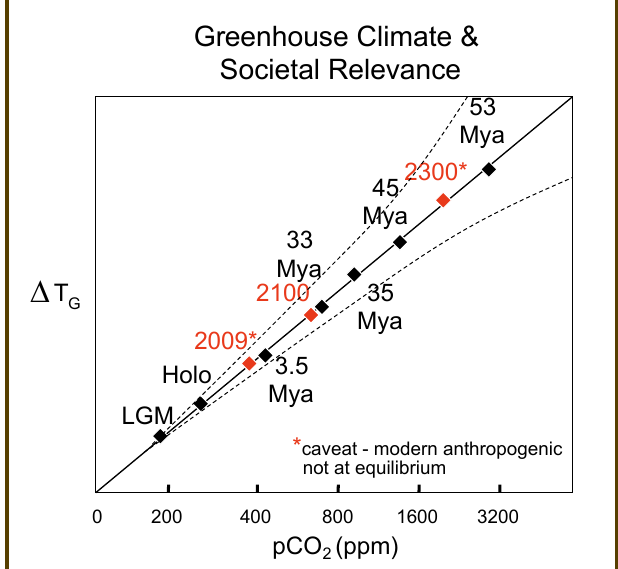
Figure 5. Schematic diagram showing the potential of the geological record to constrain climate sensitivity estimates across a range of pCO 2 values. Ocean drilling will provide observations of global temperature change ∆T G as a function of atmospheric pCO 2 for past climates that can be compared to future predictions (Jim Zachos, personal communication during INVEST meeting; red numbers indicate calendar years now and in the future, whereas the black indicates ages in the past). For progressively higher pCO 2 , possible geological analogues are found further and further back in